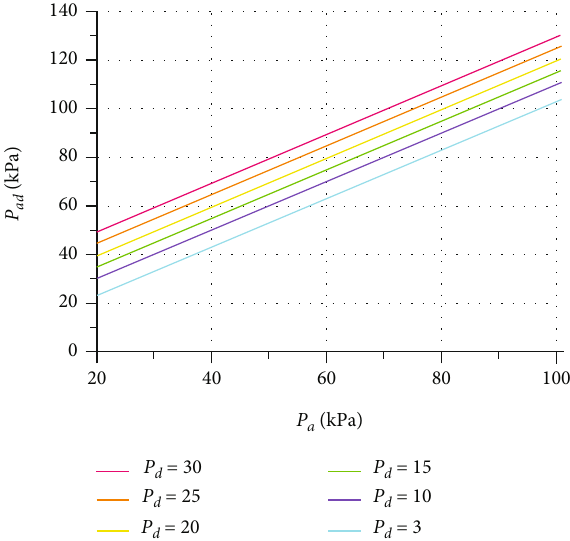
Figure 9: Relation between actuator diaphragm pressure P ambient pressure P a at di ff erent di ff erential pressure P d .